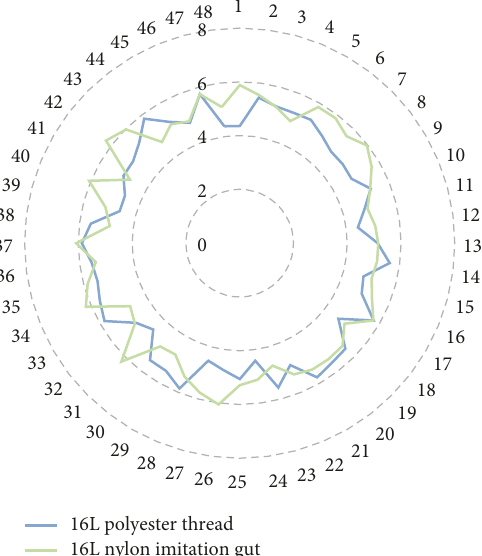
Figure 7: Statistical diagram of swing frequency of different material